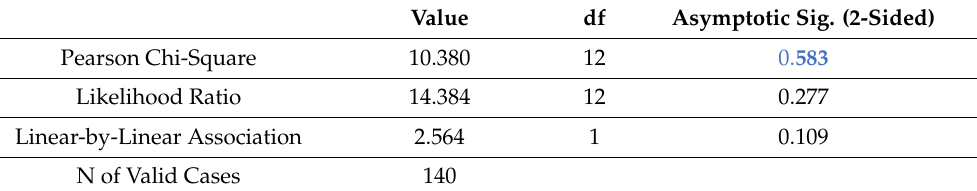
Table 17. The results for Chi-Square bivariate test.